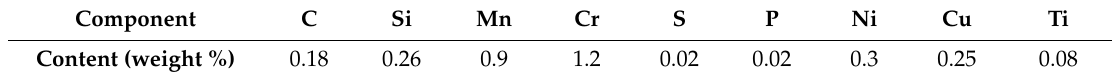
Table 3. Chemical composition of 20CrMnTiH.